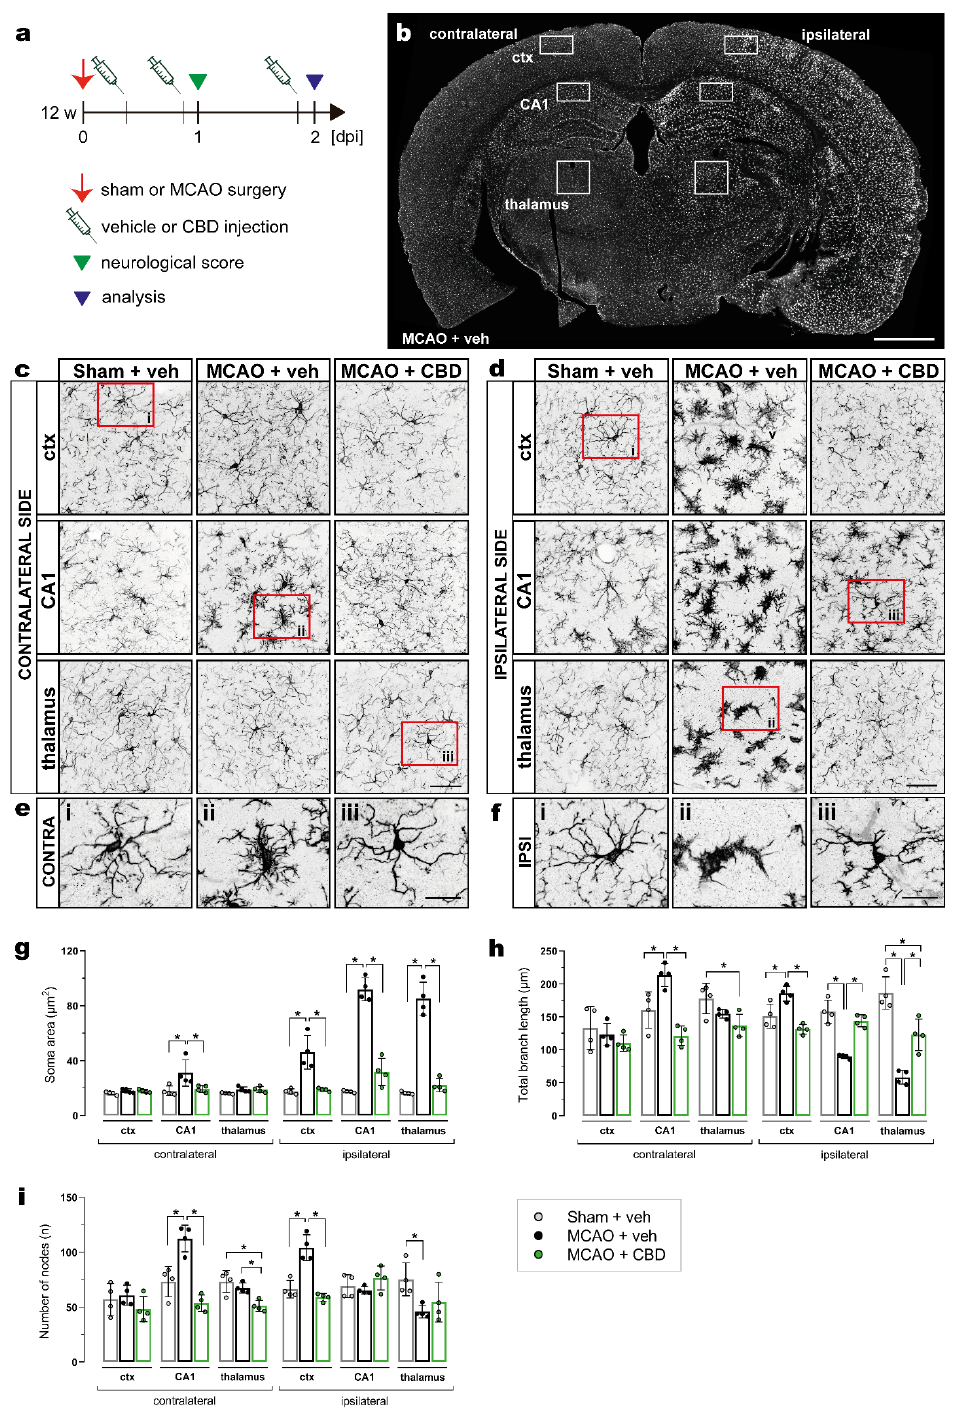
Figure 2. Reduction in ischemia-induced microglial activation by CBD treatment. ( a ) Experimental design: C57BL/6N WT mice were submitted to sham or MCAO surgery, and were injected with vehicle or CBD. Brain tissue was analyzed at 2 dpi for Iba-1 immunoreactivity. ( b ) Overview of coronal brain section showing the ctx, CA1 subfield, and thalamus, where the analysis for